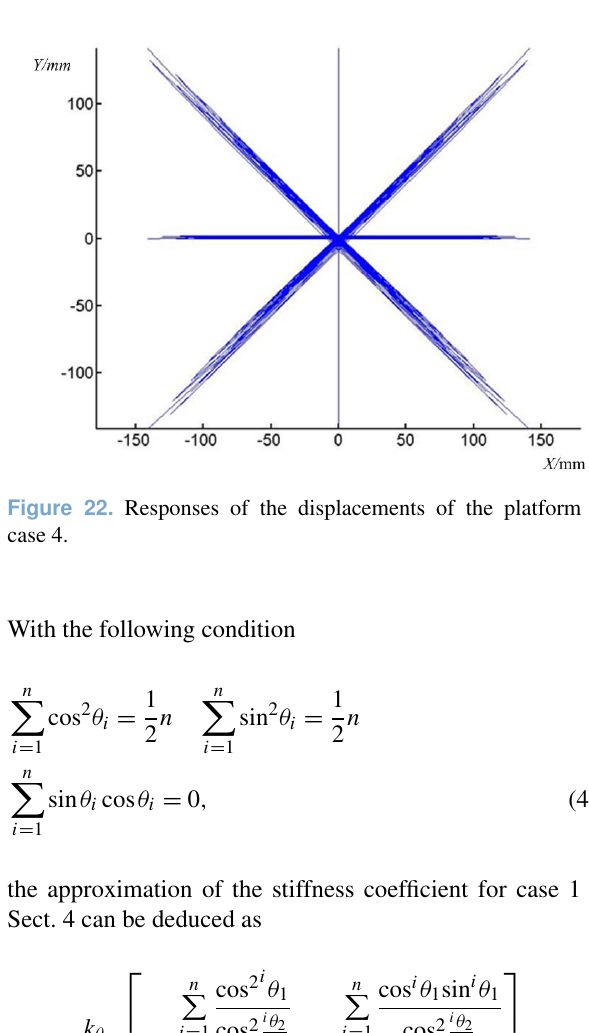
Figure 20. Cylinder springs connecting vertical joints and horizon- tal joints.